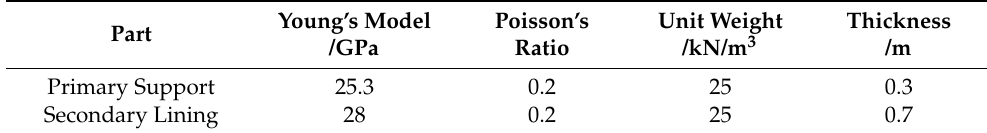
Table 2. The parameters of primary support and secondary lining.